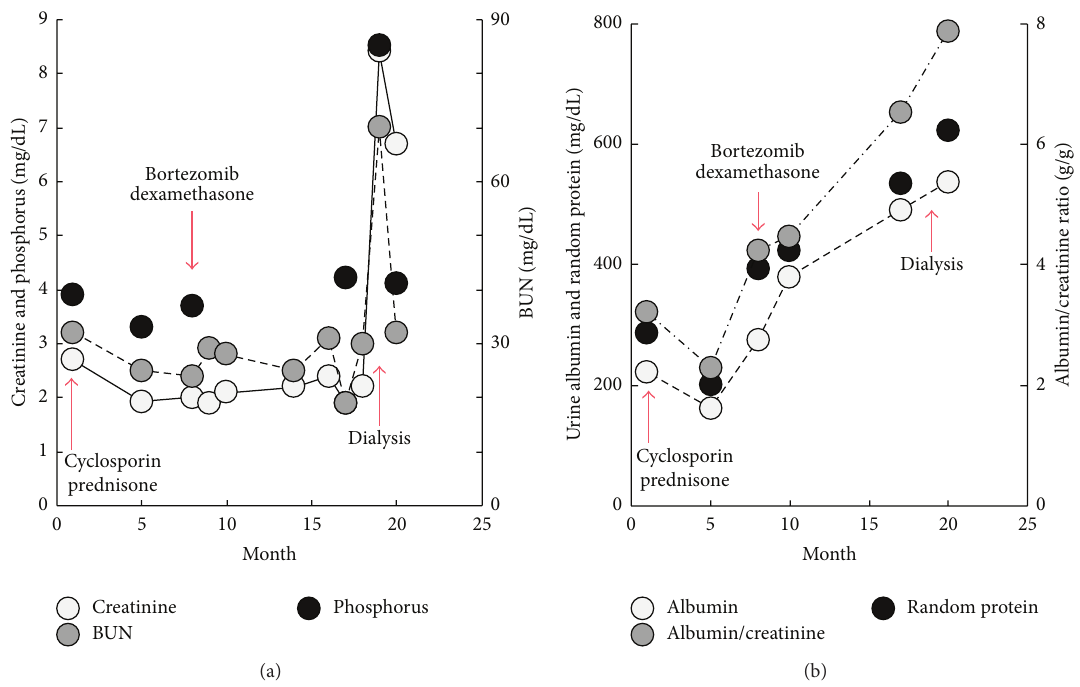
Figure 1: Laboratory values during the chemotherapy. 16-week treatment with cyclosporine followed by prednisone failed to prevent disease progression. Patient received a total of 4 cycles of bortezomib and dexamethasone, however, with no clinical or laboratory improvement. Disease progressed and patient eventually became hemodialysis